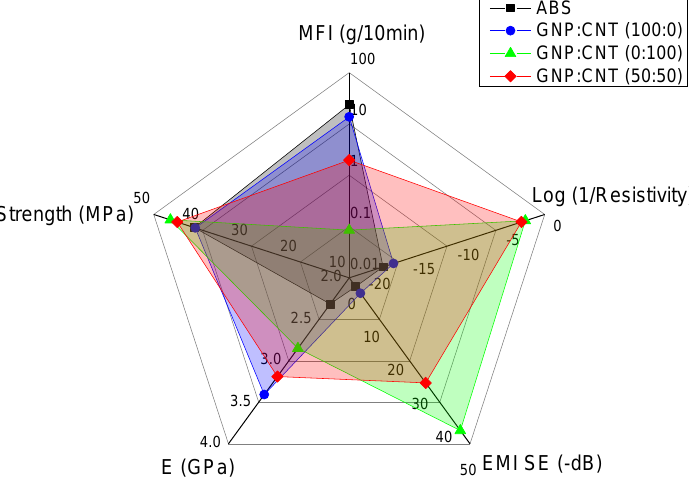
Figure 12. Comparative plot of compression molded nanocomposite at 6 wt.%. Processability (MFI), resistivity, electromagnetic shielding (EMI SE), and tensile properties of graphene, carbon nanotube, and 50:50 hybrid nanocomposites with respect to ABS matrix. Spider plots of FFF samples are reported in Figure S3 (Supplementary Materials) for comparison.